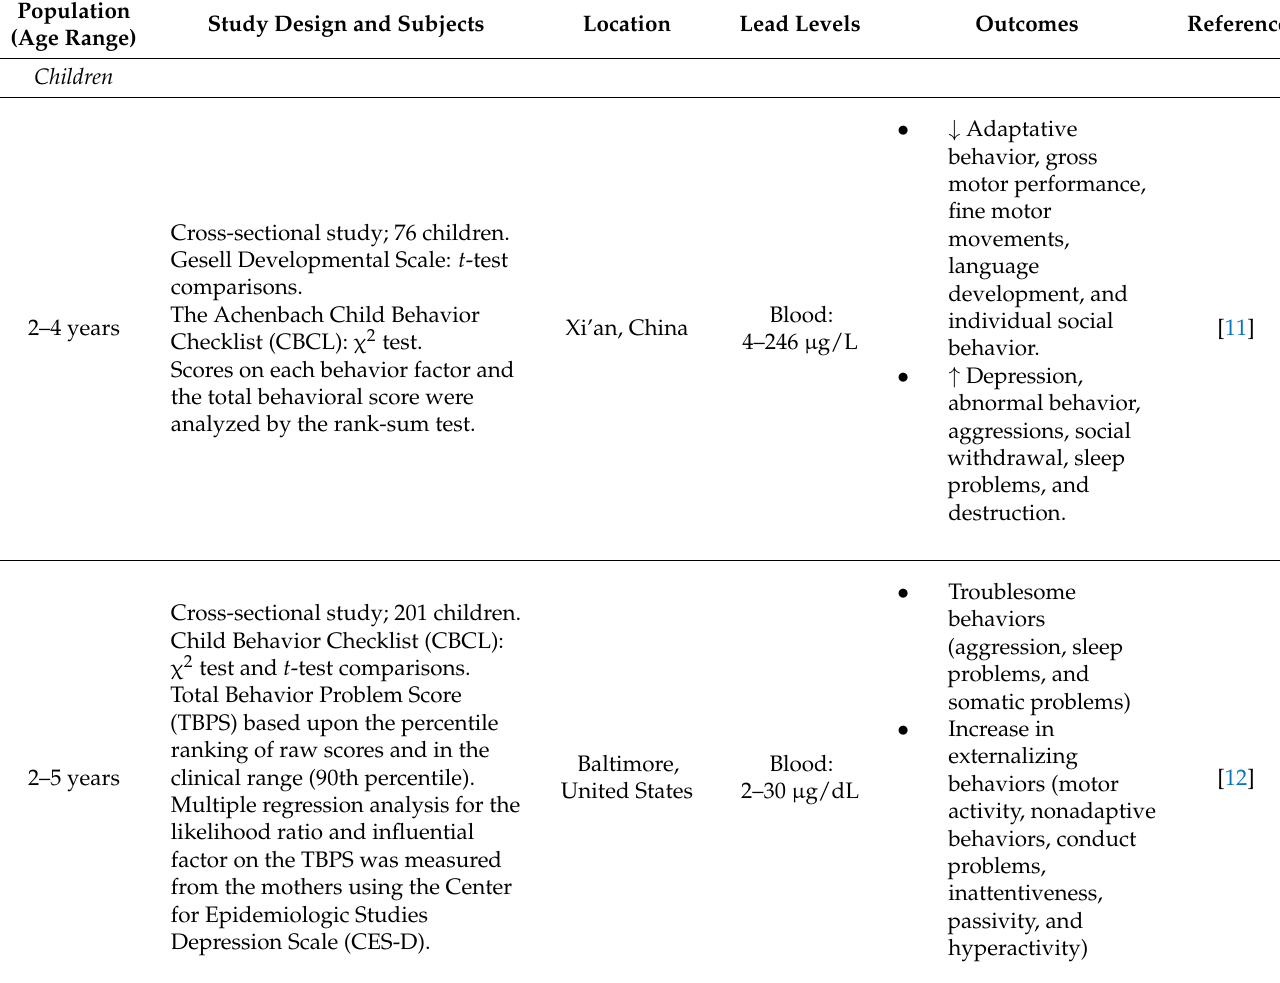
Table 1. Epidemiological studies of association between lead levels and cognitive impairment by different ages of exposure. Population Study Design and Subjects Location Lead Levels Outcomes Reference (Age Range)